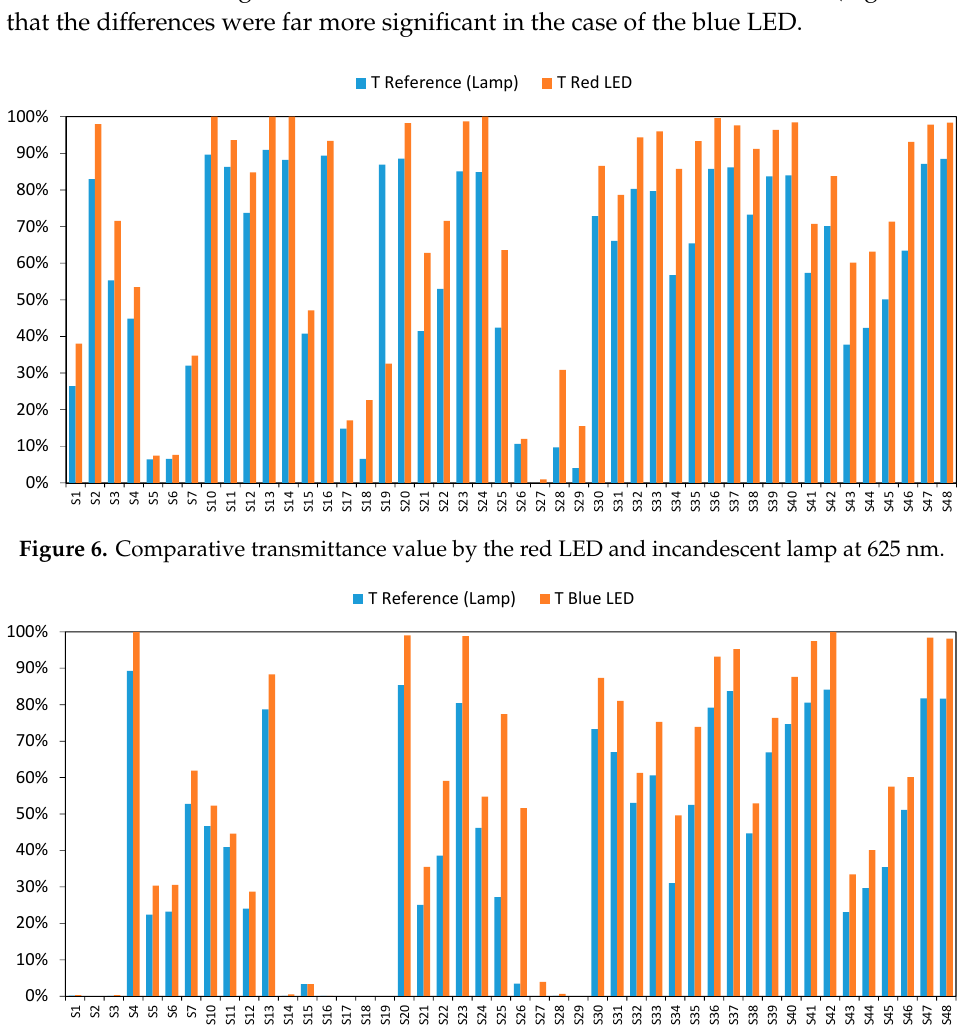
Figure 5. Comparative transmittance value by the green LED and incandescent lamp at 525 nm.